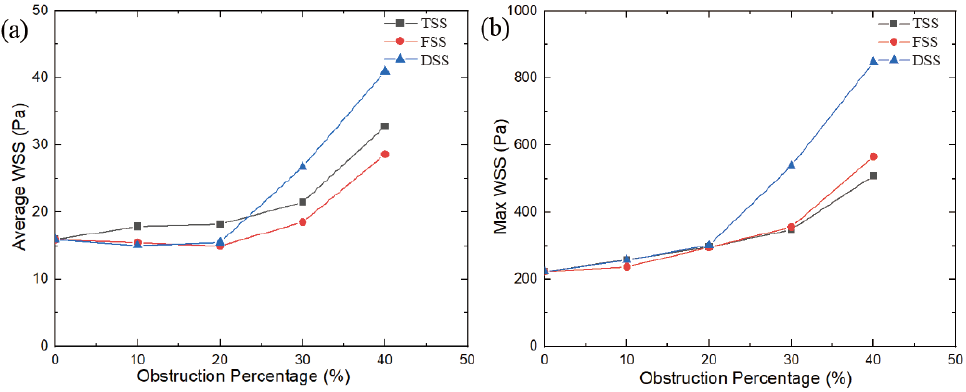
Figure 13. WSS VS obstruction percentage ( a ) Average WSS, ( b ) Max WSS ( t = 0.2 s).